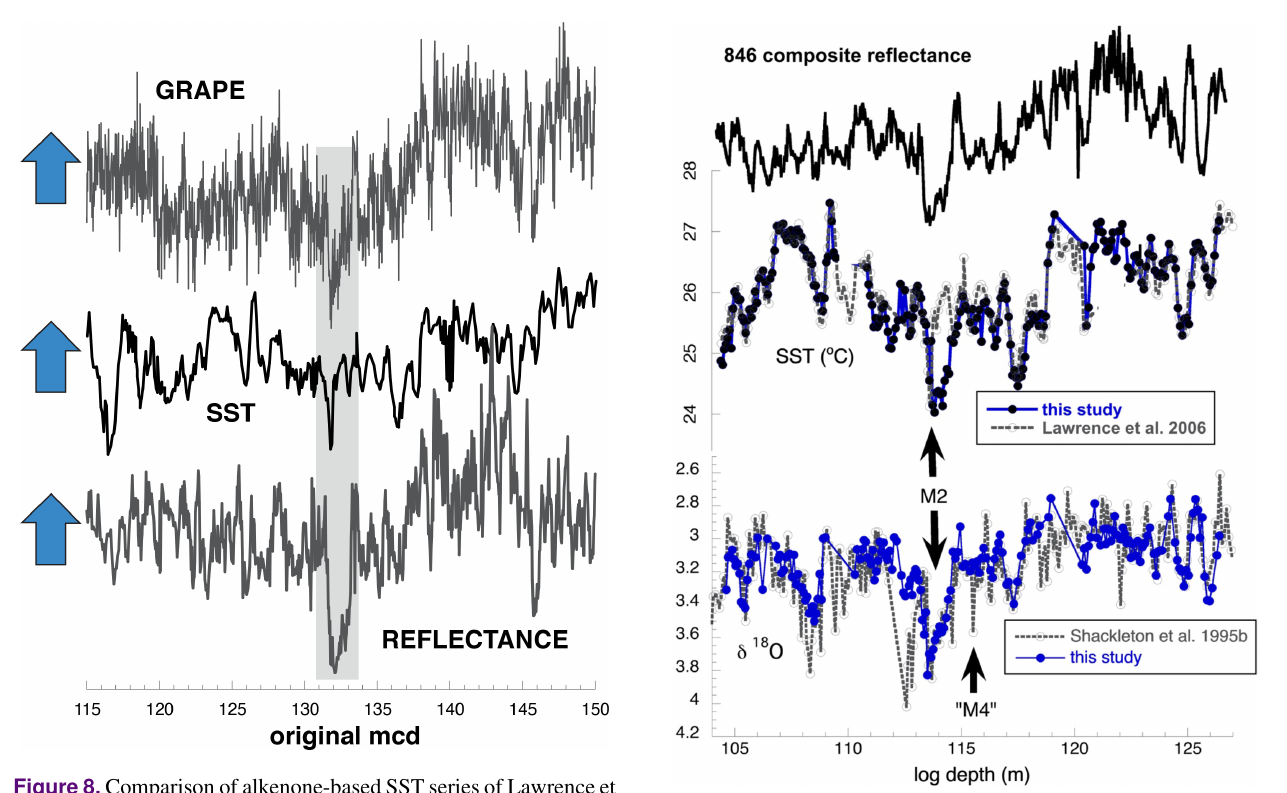
Figure 9. Revised alkenone and δ 18 O time series based on new data from Hole 846B, aligned with prior data from Shackleton et al. (1995b) and Lawrence et al. (2006), excluding the problematic intervals around the M2 glaciation (see text). The composite section has been mapped to the borehole log depth. Previously published isotopic and alkenone data in the problematic M2 interval are shown as dashed lines. Revised composite time series now align well, and the interval containing the M2 glacial event presents as a sawtooth isotopic enrichment and